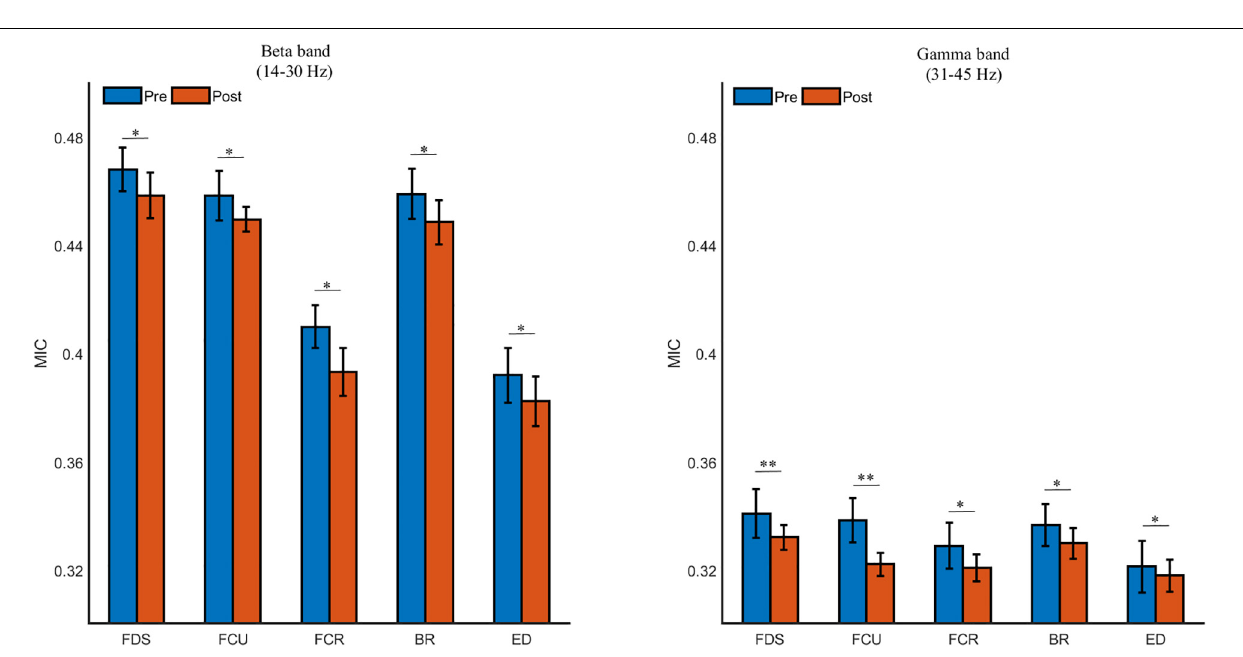
FIGURE 7 | The grand averages of the information flow for muscle network. (A) Comparison of average information flow strength in beta- and gamma-bands before and after fatigue. (B,C) Comparison of information flow strength between different muscles before and after fatigue. ∗ p < 0.05.